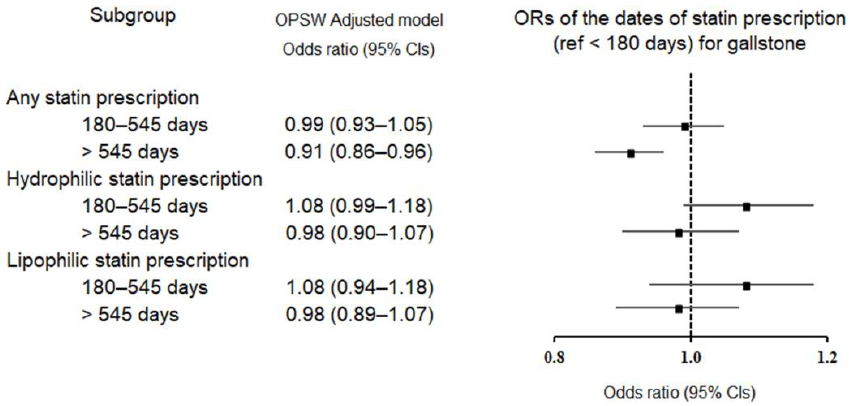
Table 2. Crude and overlap propensity-score-weighted odds ratios of incident gallstones according to statin type and duration of statin prescription.